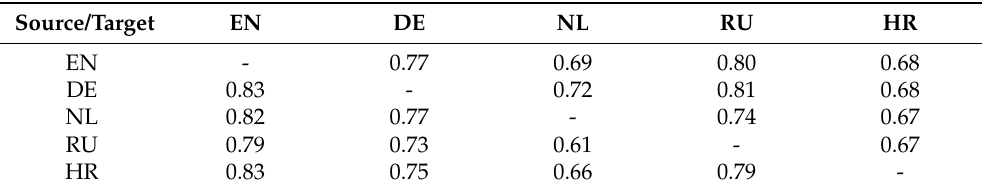
Table 4. Spearman’s correlation coefficient for MS-MiniLM model, 1000-word dictionaries. In the table, p -values for correlation coefficient values are less than